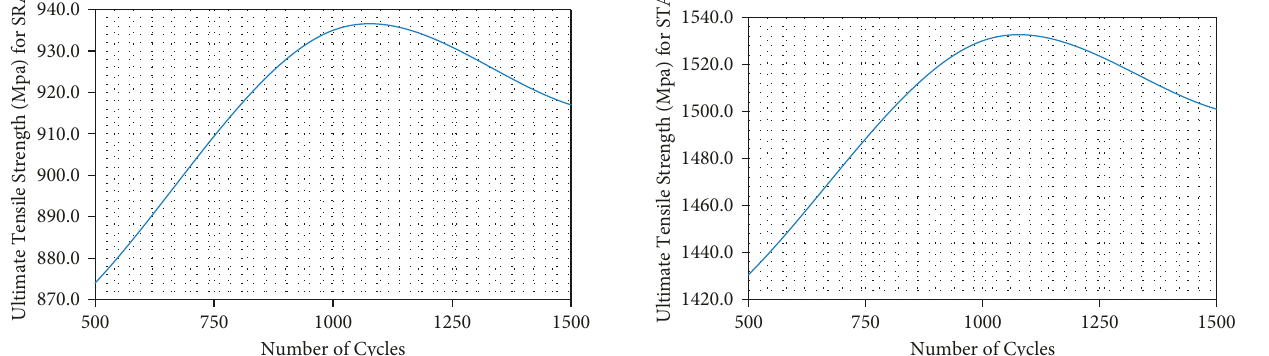
Figure 14: Ultimate tensile strength of STA.